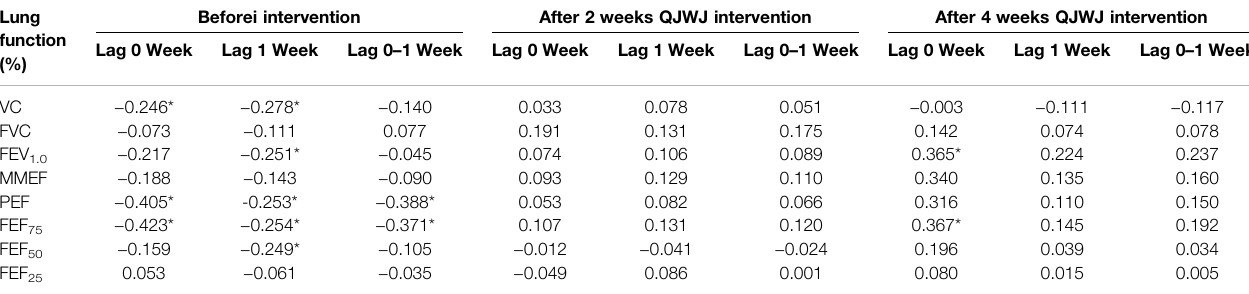
TABLE 3 | Correlation between lung function indicators and individual dose of inhaled PM 2.5 at different periods. Lung